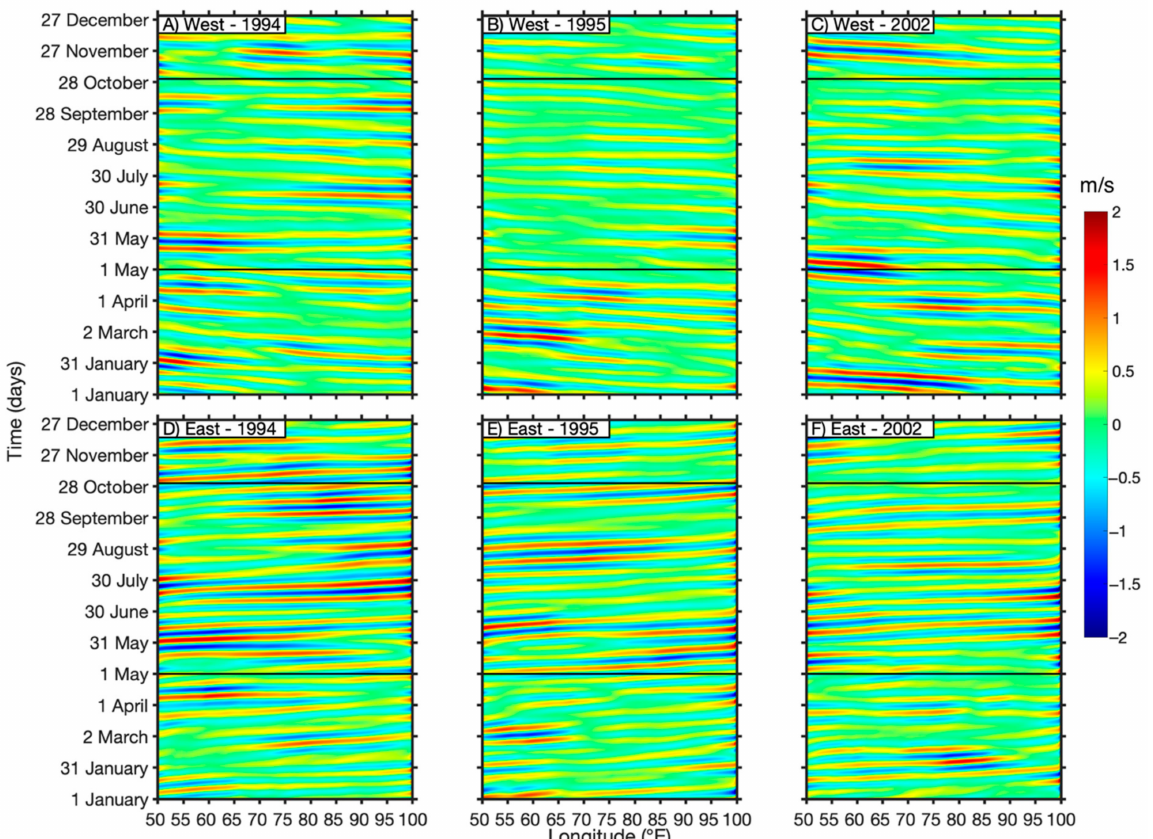
Figure 3. Time–longitude plots of 10–20-day bandpass-filtered surface wind magnitude (shaded; m/s) in the southern Indian Ocean during a strong ( A , D ), normal ( B , E ), and weak ( C , F ) monsoon season that is filtered for westward ( A – C ) and eastward ( D – F ) propagation. A positive slope indicates that a feature is moving eastward as time progresses, and a negative slope means that a feature is propagating westward. The extended southwest monsoon season (May–October) is indicated by black lines on the